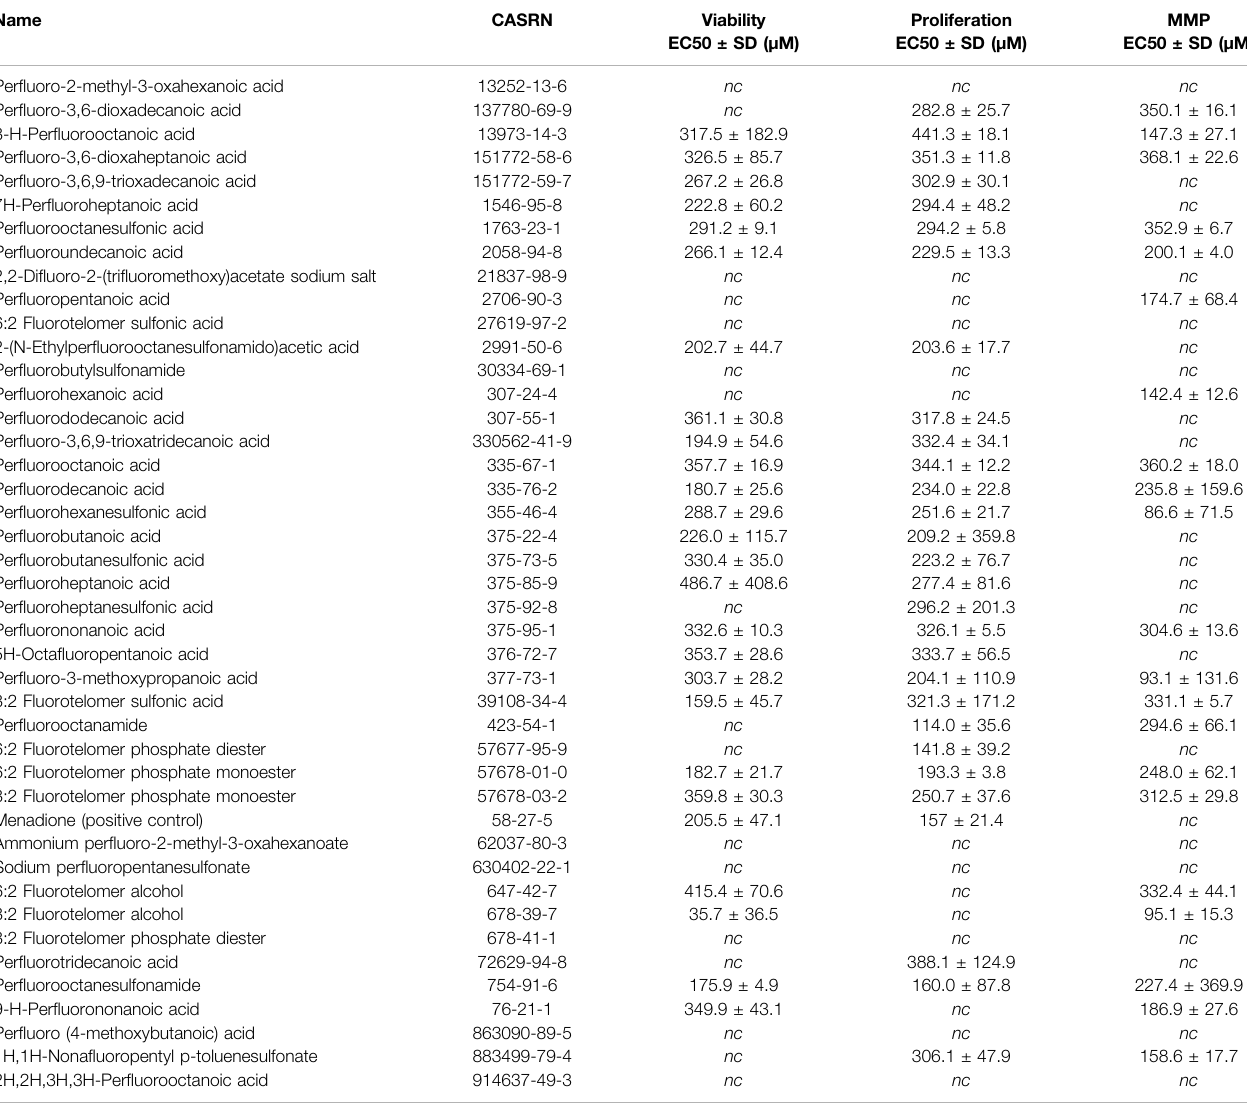
TABLE 1 | Dose-response curve EC50 estimates for JEG-3 cell viability, proliferation, and mitochondrial membrane potential (MMP) after 24 h exposure to PFAS.